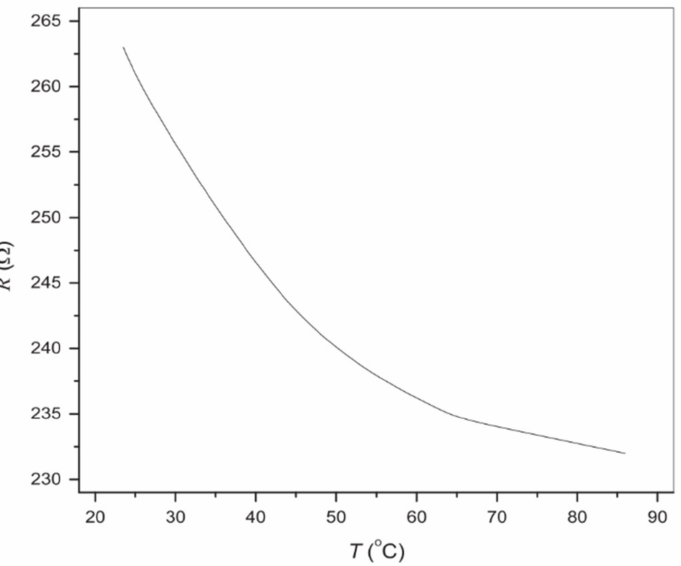
Figure 10. Resistance and temperature relationship of the CNT–GMSA composite [85]. Reproduced with